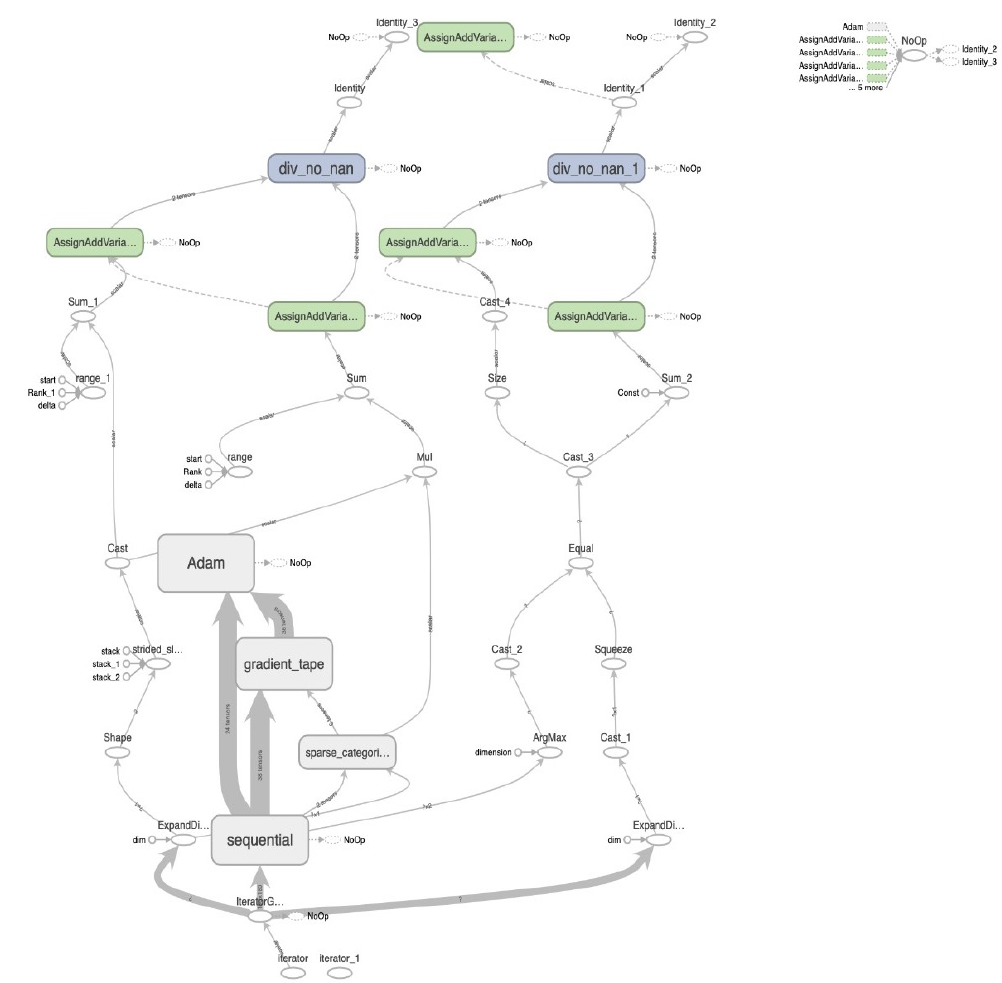
Figure 4. Data flow of our